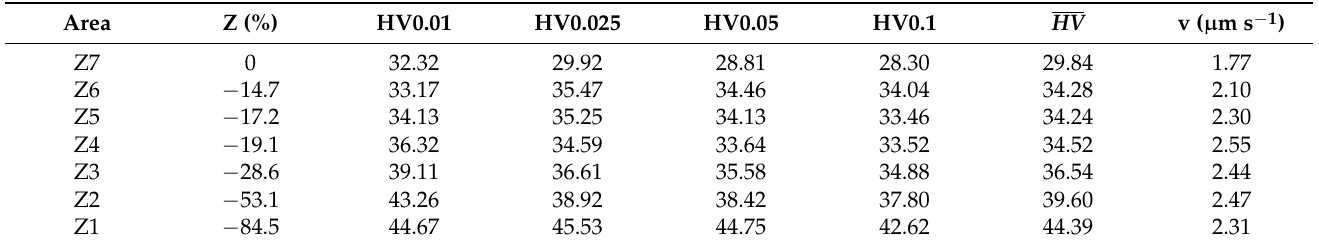
Table 1. Results of the tensile test: the reduction of the area Z (%), values of the micro-hardness and average micro-hardness 𝑯𝑽(cid:3364)(cid:3364)(cid:3364)(cid:3364)(cid:3364) , and the speed of the indenter. Area Z7 is the head and area Z1 is the neck of the tensile test sample.